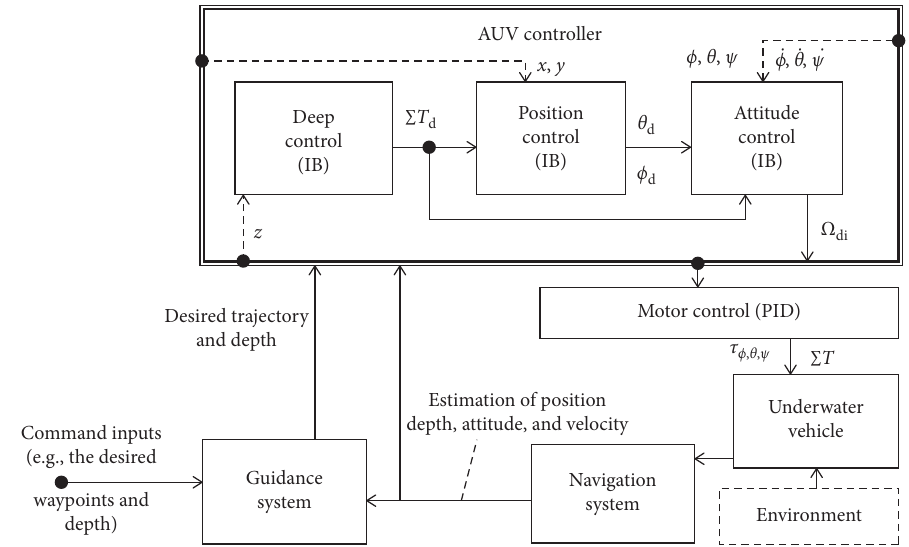
Figure 4: Proposal of a functional block diagram for implementing the continuous behaviors of the AUV